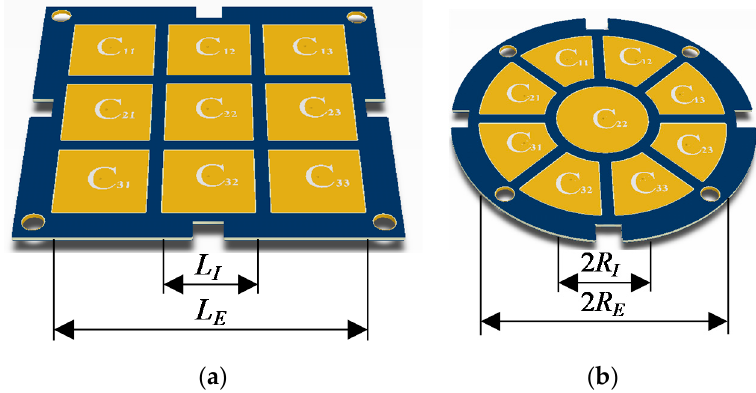
Figure 3. Proposed multi-electrode geometries: ( a ) squared electrode and ( b ) circular electrode.